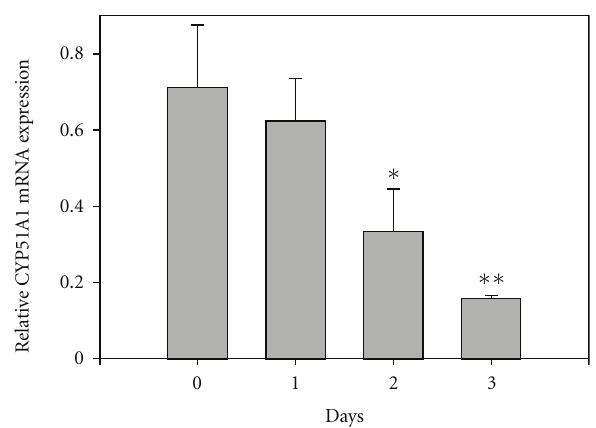
Figure 3: E ff ect of cholesterol feeding on hepatic lanosterol 14 α demethylase mRNA levels. Rats were fed a diet containing 1% cholesterol for the indicated number of days. Hepatic mRNA levels were determined by RT-PCR. Values are given as means ± Standard Error for 3 to 6 rats per time point. ∗ P < 0 . 05; ∗∗ P < 0 .